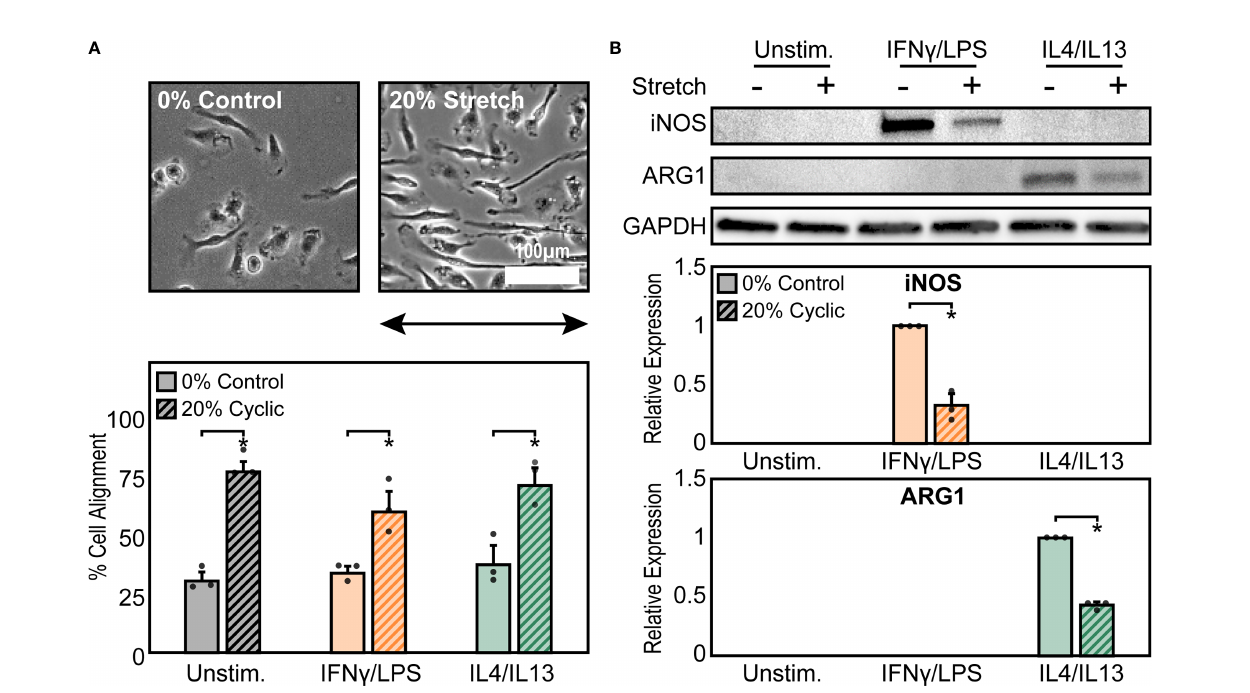
FIGURE 1 | Mechanical stretch alters macrophage morphology and activation. (A) Phase contrast images (top) and quanti fi cation of percent cell alignment (bottom) of unstimulated macrophages exposed to 0% and 20% cyclic uniaxial stretch. Uniaxial strain was applied in the horizontal direction as indicated by the arrow. (B) Representative western blots (top) and corresponding quanti fi cation for iNOS (middle) and ARG1 (bottom) for unstimulated, IFN g /LPS, and IL4/IL13 stimulated macrophages. Values were normalized to GAPDH and made relative to IFN g /LPS or IL4/IL13 stimulated and 0% stretch conditions, respectively. Error bars indicate standard deviation of the mean for three separate experiments and * p < 0.05 when compared to the indicated condition as determined by Student ’ s t-test (A) or paired t-test (B)